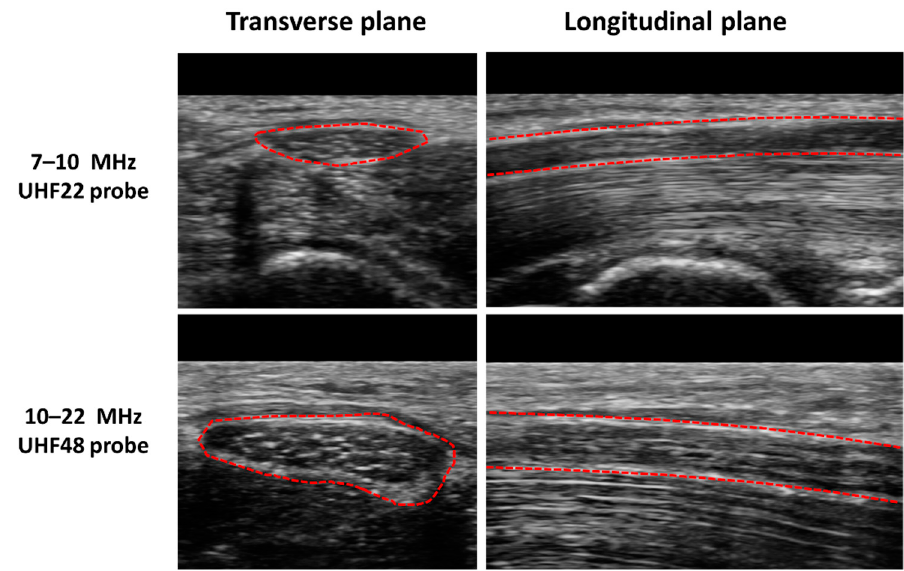
Figure 4. US B-mode images in transverse and longitudinal planes of the median nerve (indicated in red dashed lines) in a healthy volunteer generated with UFH22 (7–10 MHz) and UFH48 (10–22 MHz) US probes on a Vevo MD, FUJIFILM machine. The honeycomb-like structure of the nerves in the transverse plane becomes more obvious in images generated with higher-frequency